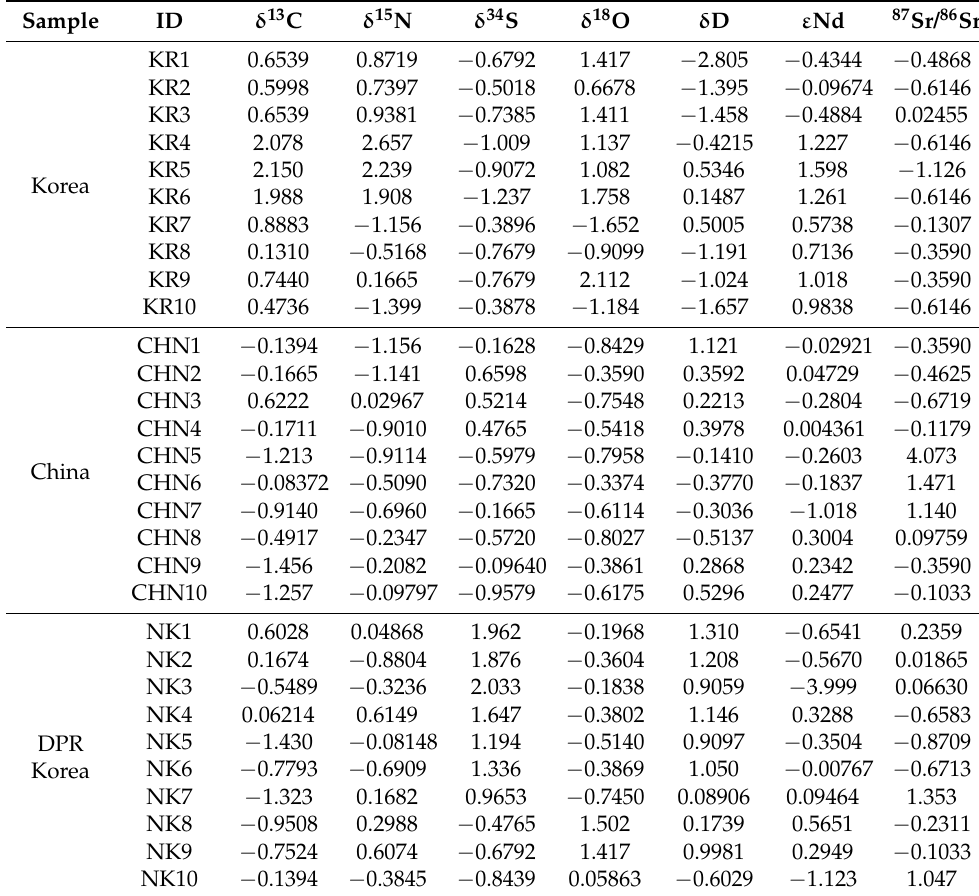
Table 2. The data (stable isotope) set transformed and normalized by Z-score for statistical processing (linear discriminant analysis, LDA) in this